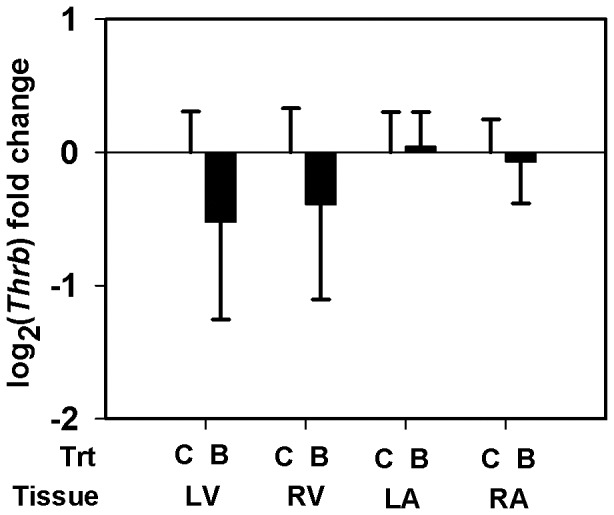
Real-time PCR quantification of thyroid hormone receptor beta (Thrb) expression.Transcript levels of Thrb in the left ventricle (LV), right ventricle (RV), left atrium (LA) and the right atrium (RA) of rhesus monkey (Macaca mulatta) fetuses at birth. Fetuses were exposed maternally to a 400 µg/Kg. body weight of BPA dose (B) or 150 µL ethanol (C) during late gestation (LG, days 100±2–term). Data were analyzed by tissue and bars represent the mean ± S.E.M. of the log2 (fold change). A two sample t-test was performed to identify significant BPA effects and a two-tailed p≤0.05 was considered statistically significant.